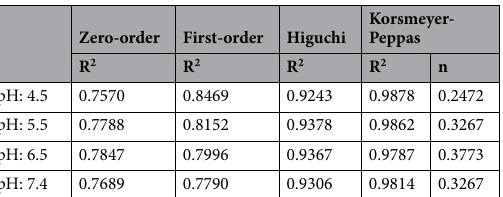
Table 2. Values of the correlation coefficient and release exponent obtained for mathematical models applied to DOX release from chitosan nanoparticles.